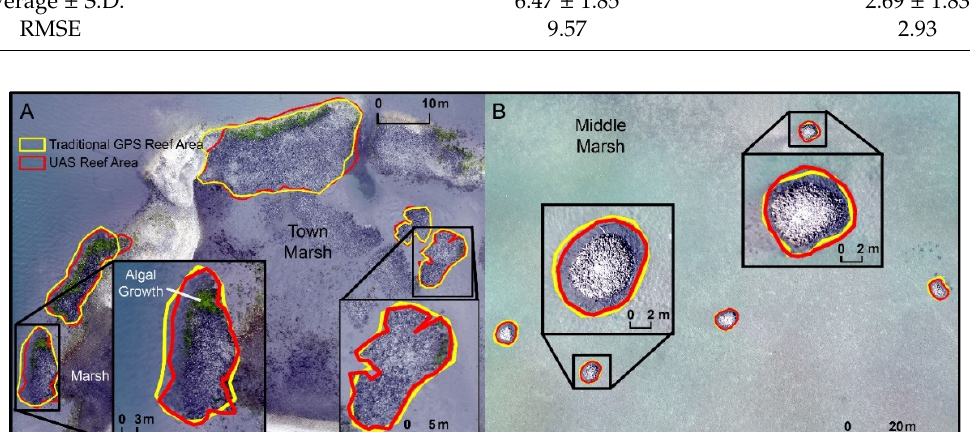
Figure 5. Intertidal oyster reef boundaries from eBee fixed-wing UAS imagery (red) and RTK GPS derived polygons (yellow) of fringing oyster reefs located in Town Marsh ( A ) and restored patch reefs in Middle Marsh ( B ) Rachel Carson Reserve, Beaufort, NC.